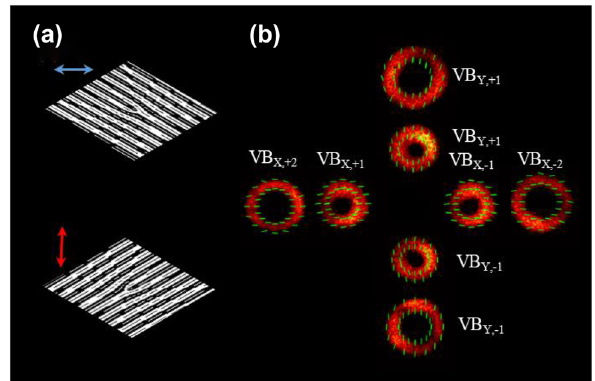
Figure 5: Experiment performance of more OAM modes multiplexing. (a) Two Dammann vortex grating phases with mutually perpendicular off-axis phases. (b) The intensity and polarization distributions of the different diffraction